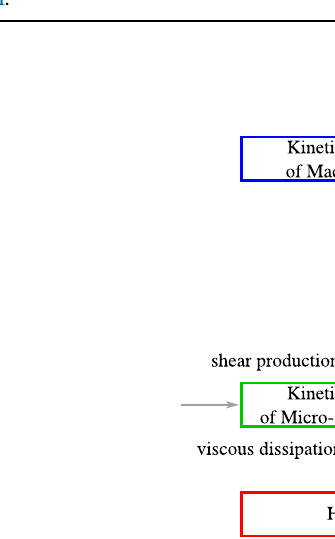
represent the input of energy from external forcing (energy could also be lost to these